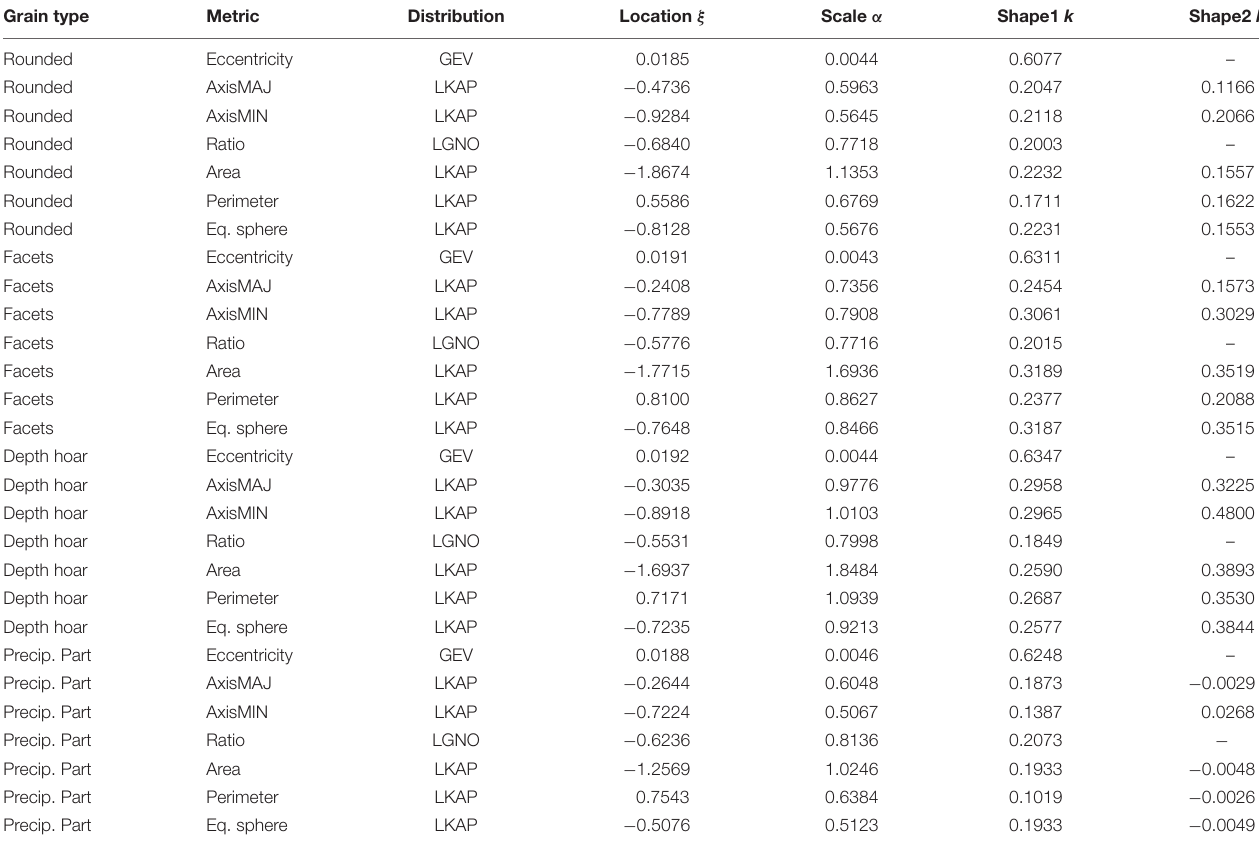
TABLE 3 | Statistical fits summary for classified snow grains for the distribution of the log transformed data.